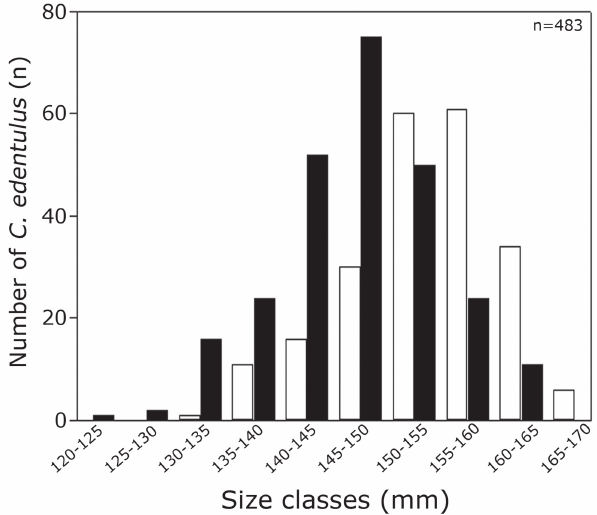
Fig. 2. Number of Cetengraulis edentulus per size classes (mm) of total length (white column = female; black column = male) in Guanabara